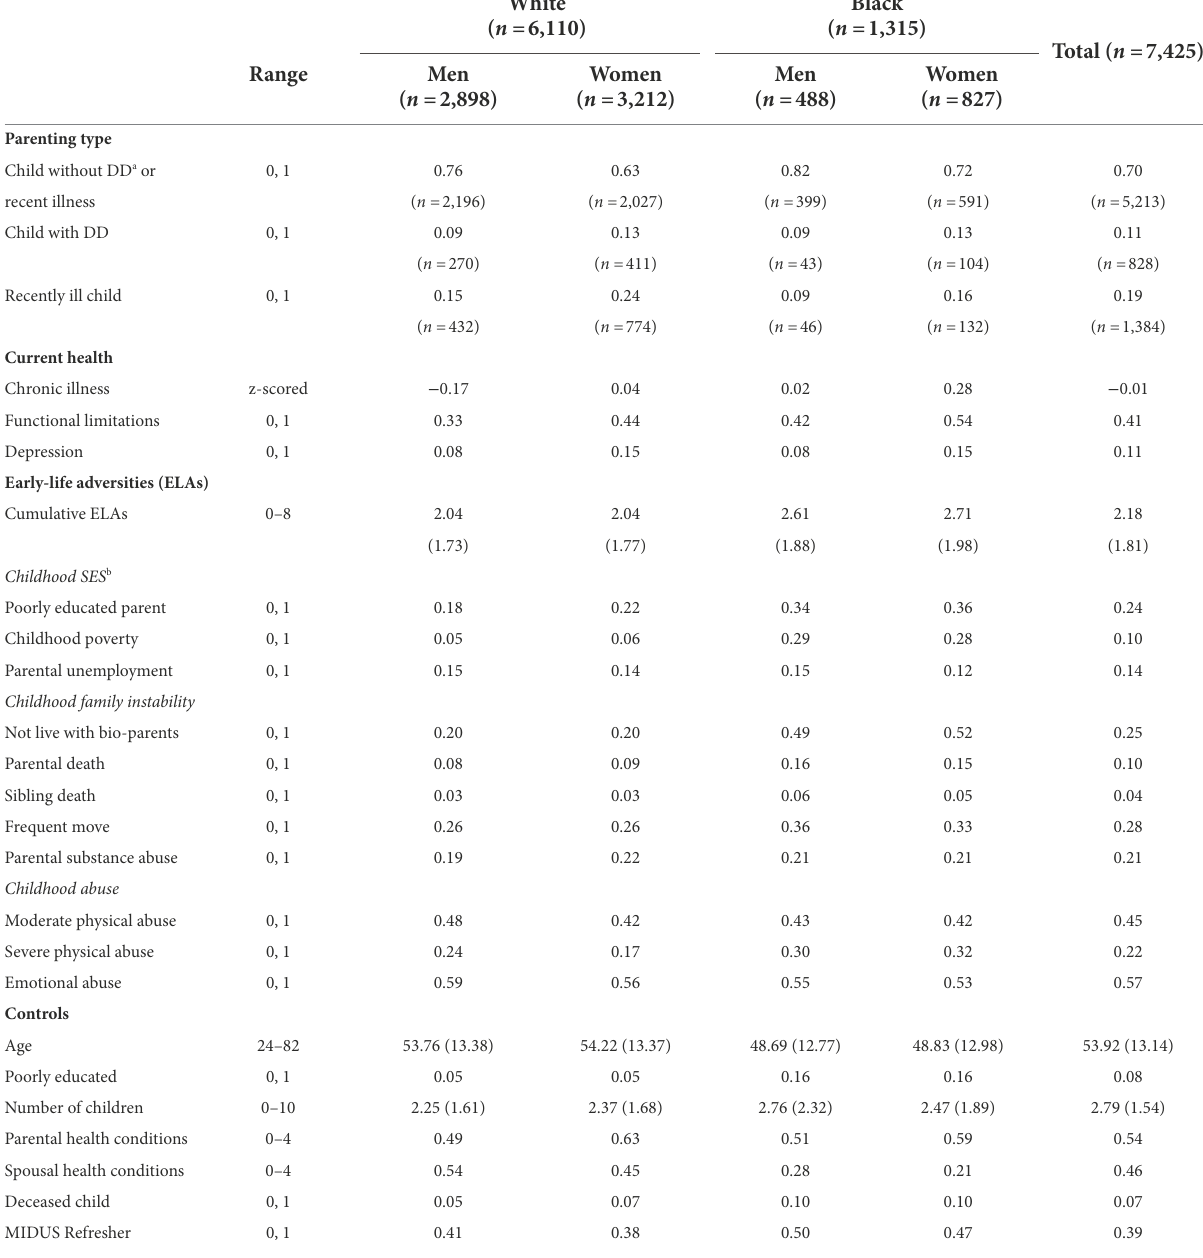
TABLE 1 Means (and standard deviations) or proportions for all variables used in analysis by race and gender (n =